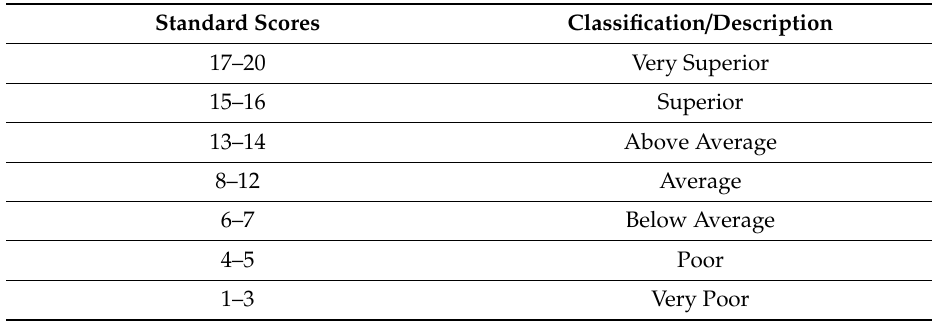
Table 1. The Peabody Developmental Motor Scales—Second Edition (PDMS-2) subtest standard score values with the associated classification /